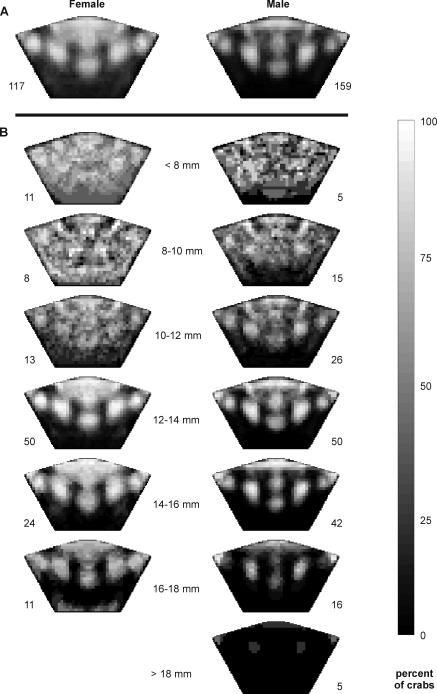
The likelihood that any point on the carapace is coloured.The proportion of males and females in general (a) and within various size classes (b) that are coloured in a particular area is indicated by brightness. Black represents no crabs with colour in that area and white signifies all crabs coloured in that area. Sample sizes are indicated at the base of each image.